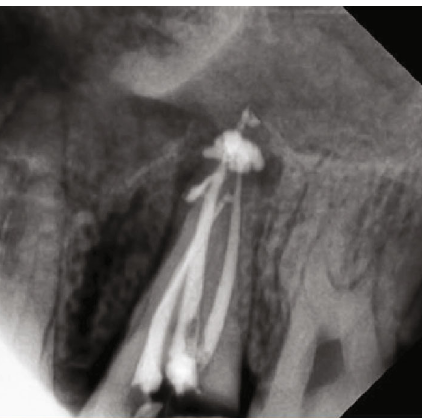
Figure 6: Upper left fi rst molar with calcium hydroxide shows the tooth with direct contact with sinus.